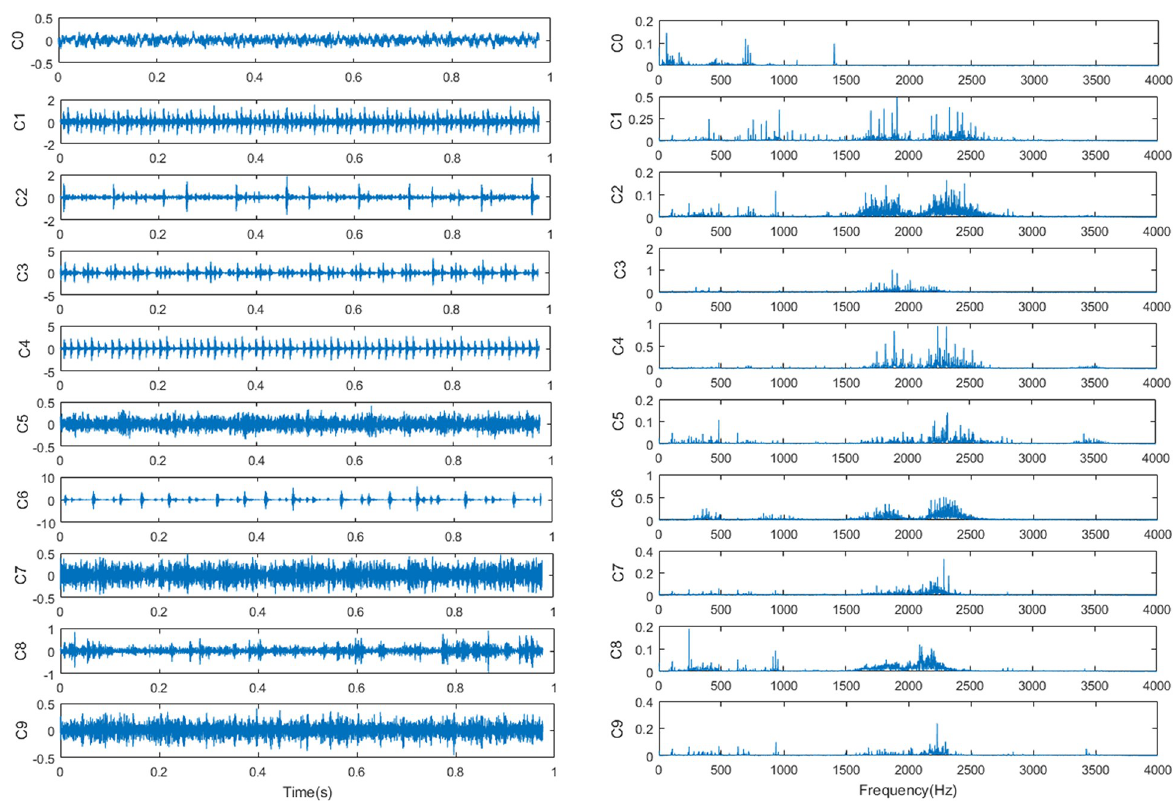
Fig 9. The original vibration signals in the 10 health conditions. (a) the time-domain waveform and (b) the corresponding frequency spectra. https://doi.org/10.1371/journal.pone.0246905.g009 4.2.2 Different signal-to-noise ratio dataset. In actual fault diagnosis, the sample signal usually contains a lot of noise, which makes the diagnosis performance of the model unsatis- factory. Therefore, in our experiments, Gaussian noise with different signal-to-noise ratio (SNR) from -6 to 10dB is added to data set A to test the recognition rate of the model, so as to verify the anti-noise performance of the model. SNR is defined as follows: